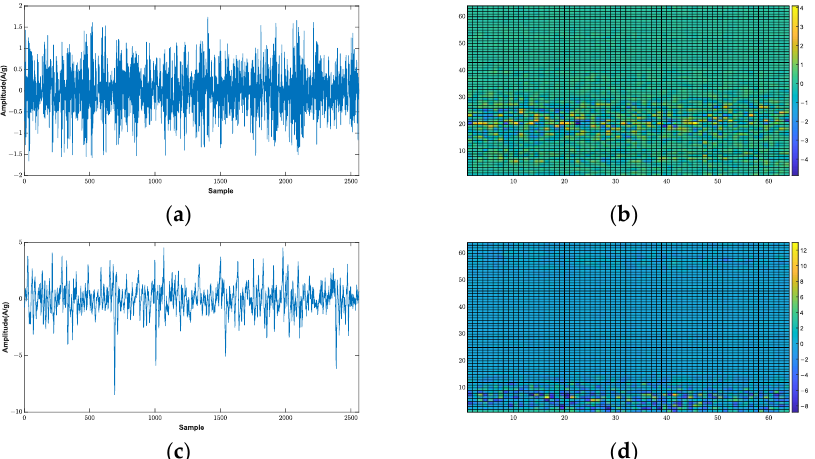
Figure 9. Visualization of raw signal and wavelet packet coefficient; ( a ) Raw signal at the beginning of the degradation process; ( b ) Wavelet packet coefficient at the beginning of the degradation process; ( c ) Raw signal at the end of the degradation process; ( d ) Wavelet packet coefficient at the end of the degradation process.